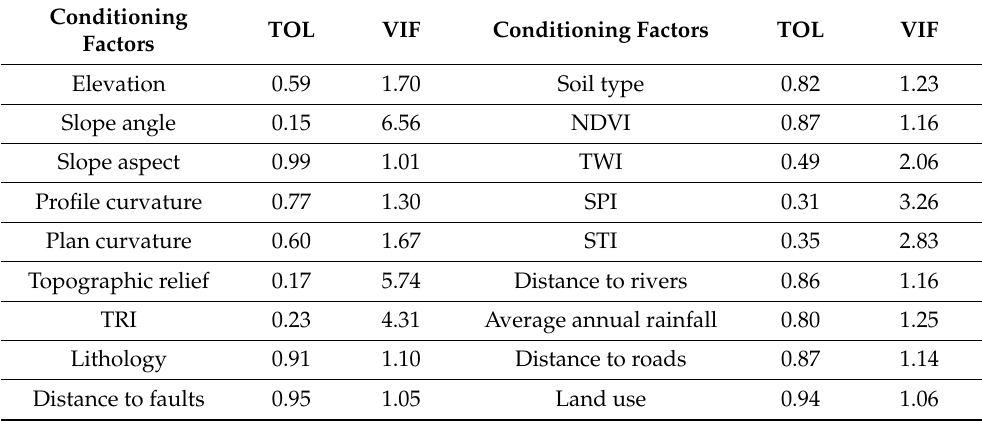
Table 4. Multicollinearity analysis of conditioning factors.